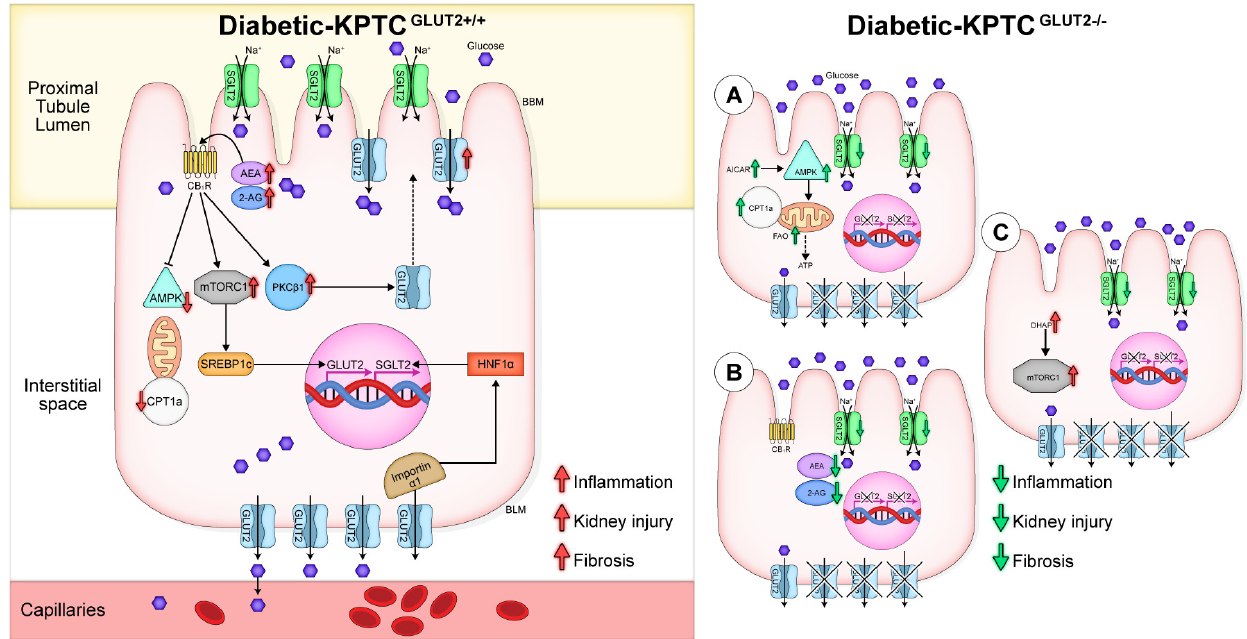
Figure 6. Suggested mechanisms by which GLUT2 nullification in KPTCs affects the de- velopment of DKD. Under diabetic conditions, enhanced GLUT2 expression and its apical translocation from the basolateral membrane (BLM) to the apical brush border membrane (BBM) along with elevated SGLT2 expression result in cellular glucotoxicity, increased endocannabinoid ‘tone’, and overactivation of mTORC1. All together, these effects lead to reduced fatty acid oxidation (FAO), and consequently to kidney injury, inflammation, and fibrosis (left panel). KPTC-GLUT2 nullification results in reduced SGLT2 expression, decreased glucose absorption, glycosuria, and restored FAO via activation of AMPK/CPT1a signaling ( A ). Moreover, KPTC-GLUT2 nullification reduces cellular endocannabinoid/CB 1 R signaling ( B ); however, it may lead to increased levels of DHAP that activates mTORC1 signaling, which may alter kidney function in a late phase ( C ).